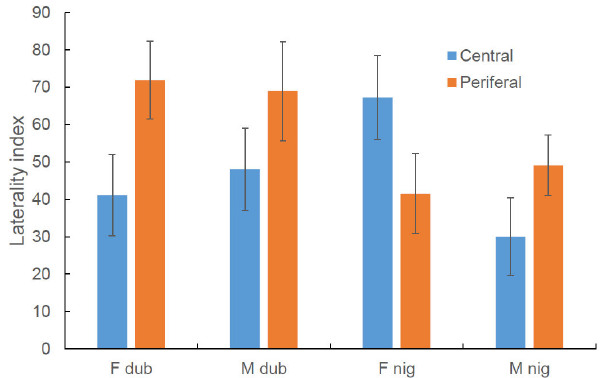
Figure 6. The mean (±SE) laterality index of male (M) and female (F) rainbowfish from two species; M. duboulayi and nigrans taking up central or peripheral locations in a school of four fish. Note the statistics are based on logistic models using log (laterality index). 10